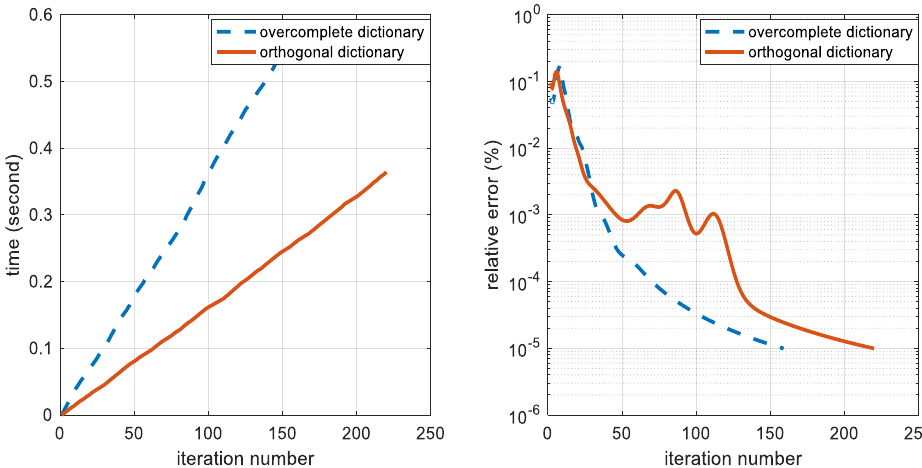
Figure 7. Comparisons of runtime and convergence performances of the proposed algorithm with orthogonal dictionary (size is 100) and overcomplete dictionary (size is 150).